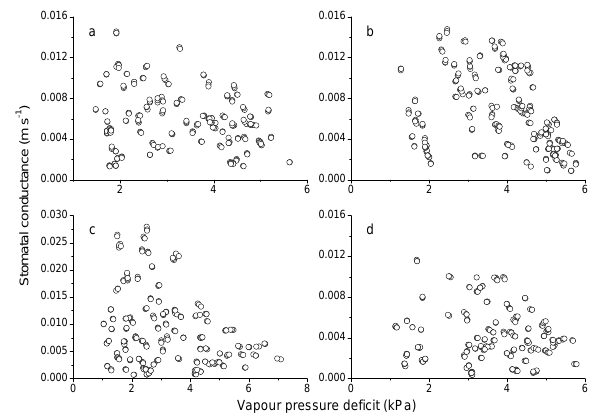
Fig. 5. Comparison between measured bulk canopy resistance de- rived from P-M model and predicted values obtained by the J-D (a) and the N-P (b)